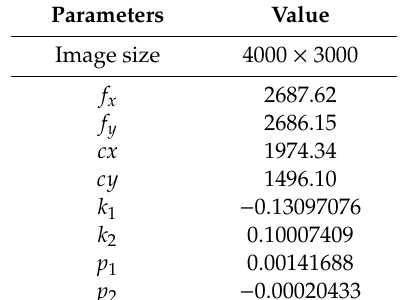
Table 1. Parameters of the camera carried on the DJI Phantom 4. f x and f y are the focal lengths expressed in pixel units; ( cx , cy ) is a principal point that is usually at the image center; k 1 and k 2 are